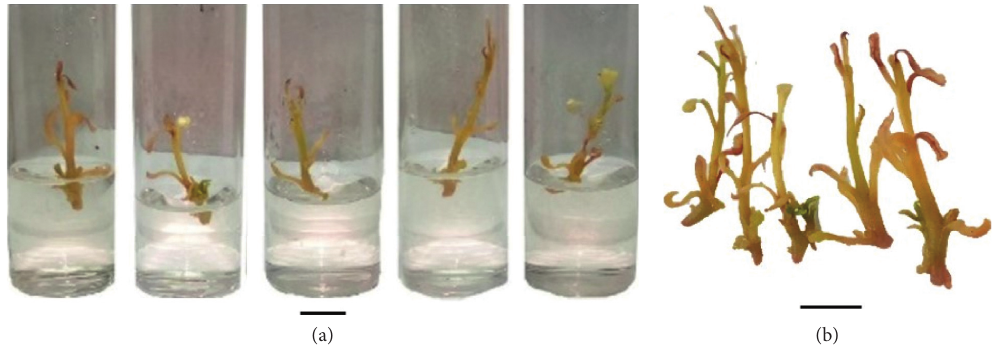
Figure 3: Vitrification of shoots caused by higher BAP concentrations. (a) Vitrified shoots inside the glass tubes; (b) vitrified shoots taken out from the medium. Scale bars represent one cm separately for panels A and